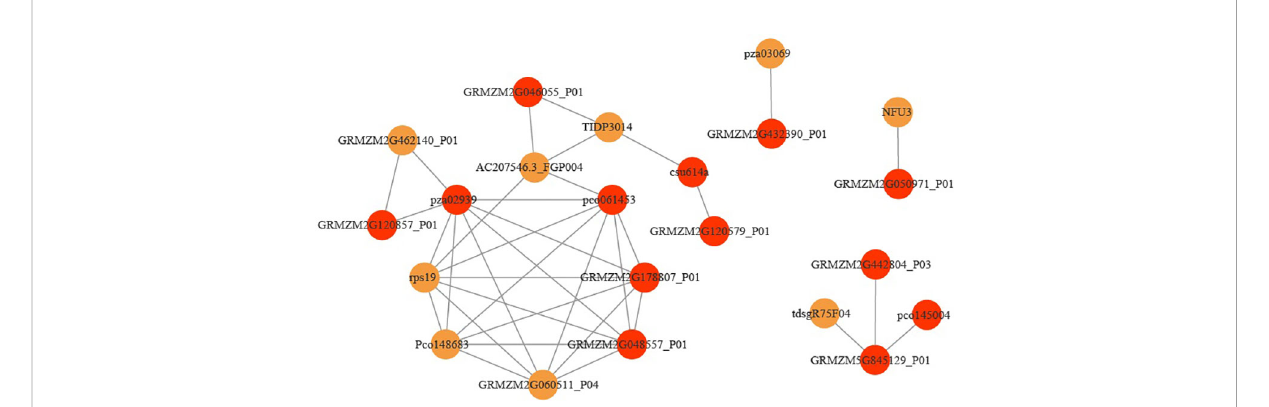
FIGURE 10 Co-expression regulatory network analysis of the hub genes. Red represents hub